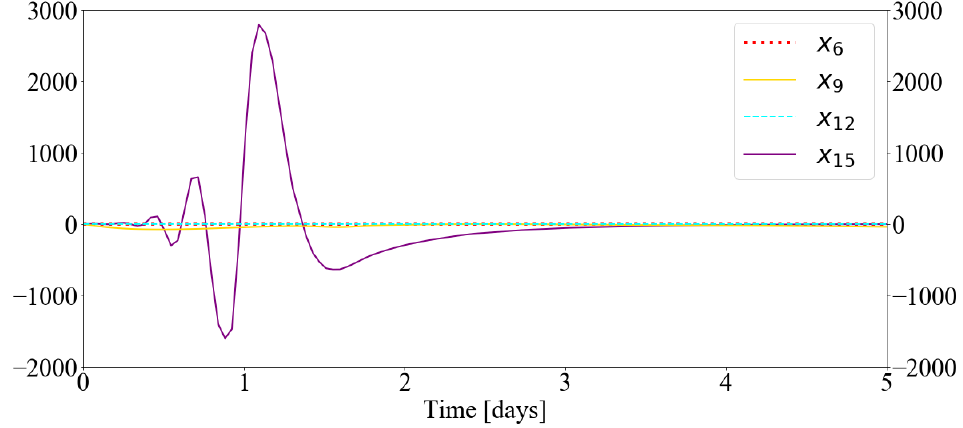
Figure 10. Sensitivity functions x 6 , x 9 , x 12 , and x 15 are the sensitivities x 3 with respect to λ 1 , λ 2 , λ 3 , and λ 4 over time, respectively. The simulation was computed for the initial state x 1 = 14.5148, and x = 0.03047. The solution is more sensitive to variations in the parameters x 2 3 0 0 λ 2 = k y and λ 4 = zc 0 than to variations in the parameters λ 1 = ρ m and λ 3 = µ m . We performed the simulation and plotting in Octave 5.1.0.0 and Python 3.7.1,